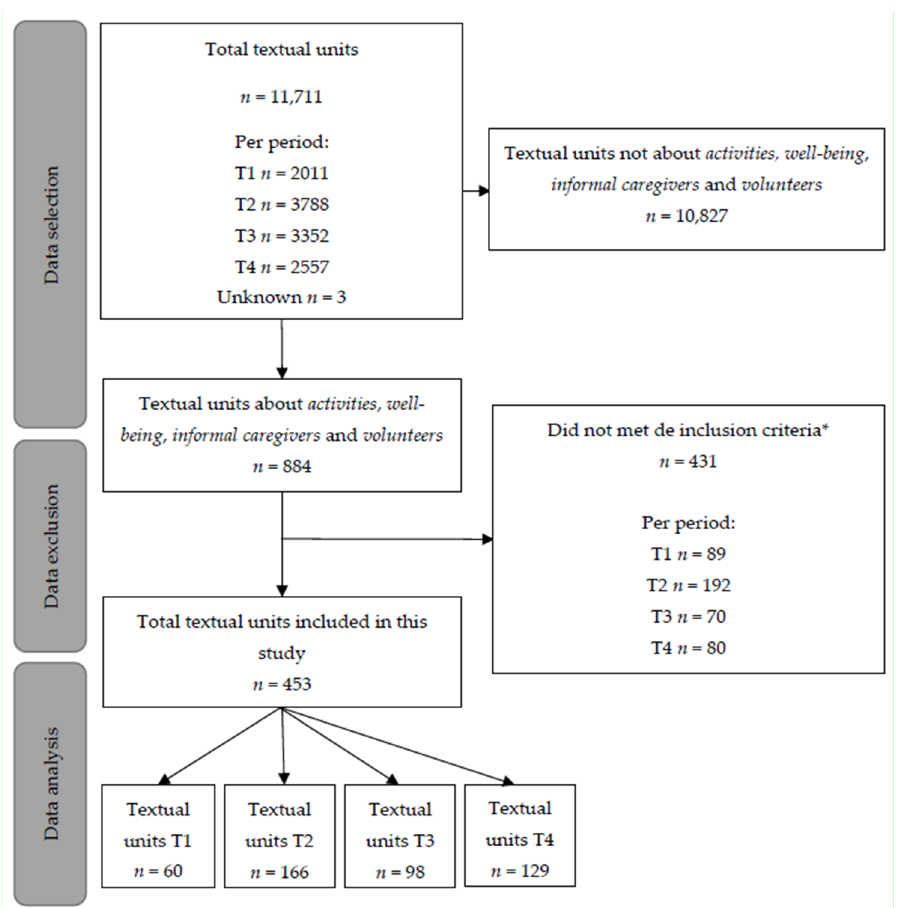
Figure 1. Flowchart of the included textual units per time period. Note: T1 is the first wave, T2 is the intermediate period, T3 is the second and third wave, and T4 is the vaccination period. * Exclusion criteria were: activities with a therapeutic aim, not in long-term care, concerning family caregivers and volunteers without mentioning activities, or were unclear.